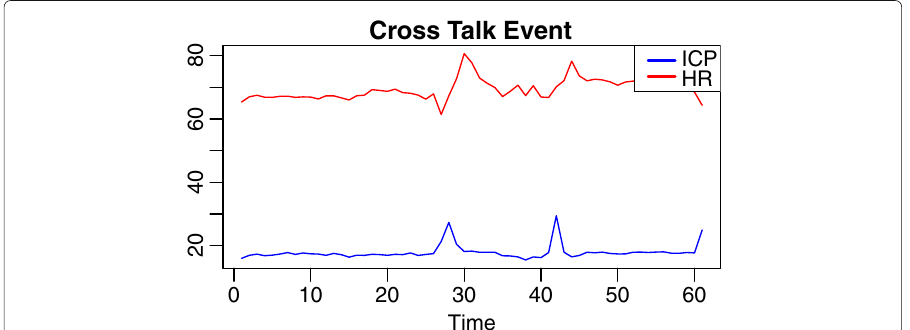
Fig. 3 Cross Talk Event Event Plot. The figure shows the plot of HR and ICP time series, in a time window where a cross talk event is